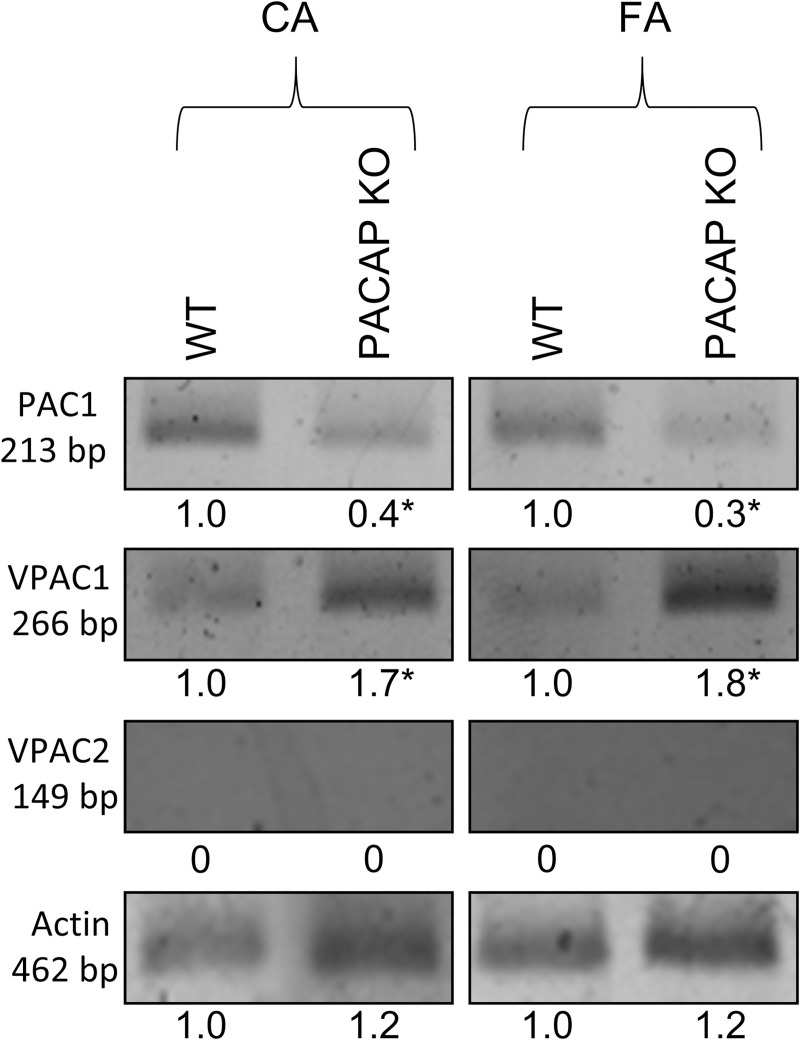
mRNA expression of PAC1R, VPAC1R and VPAC2R in femoral artery (FA) and carotid artery (CA) of wild type (WT) and PACAP knockout (KO) mice.Actin was used as an internal control. Numbers below signals represent integrated densities of signals determined by ImageJ software. mRNA expression of representative data of two independent animal samples. *p < 0.05 vs. control (WT mice).